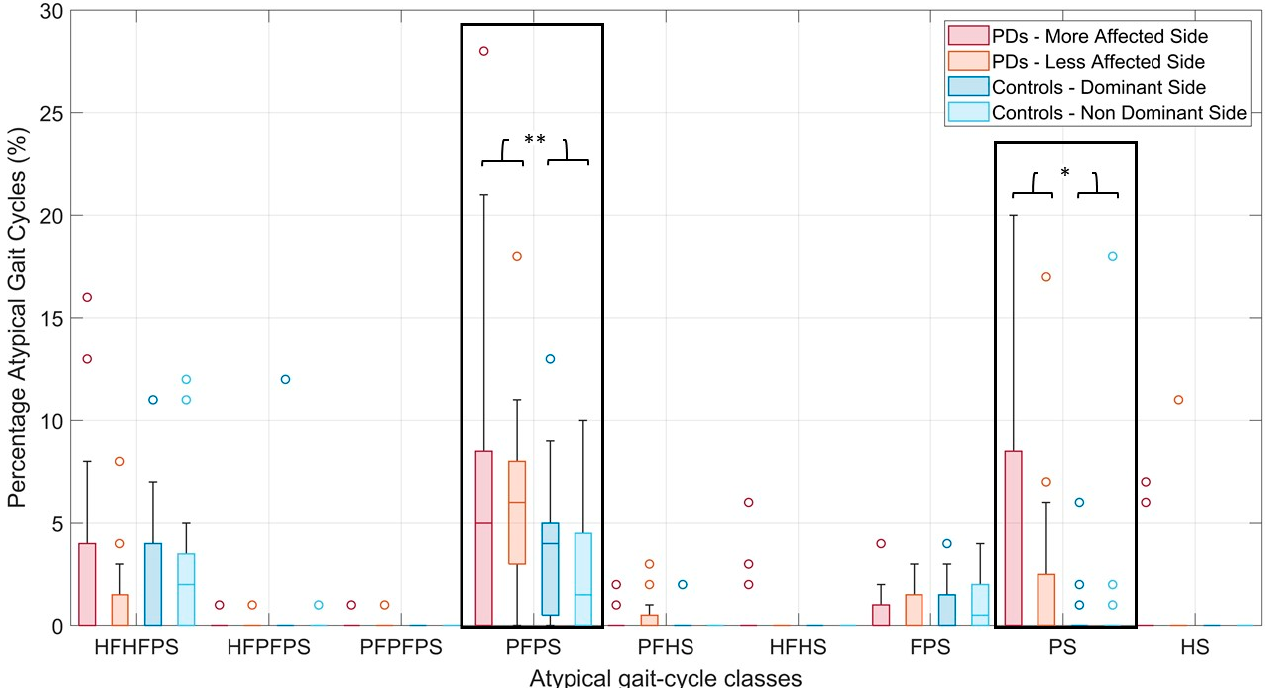
Figure 5. Boxplots of the percentage of atypical gait cycles (i.e., any gait cycle showing a foot-floor contact sequence different from HFPS) relative to the most frequently observed atypical gait-cycle classes in PD and control populations. Outliers are indicated by circles. Single and double asterisks represent statistically significant differences with p -values lower than 0.05 and 0.01, respectively .